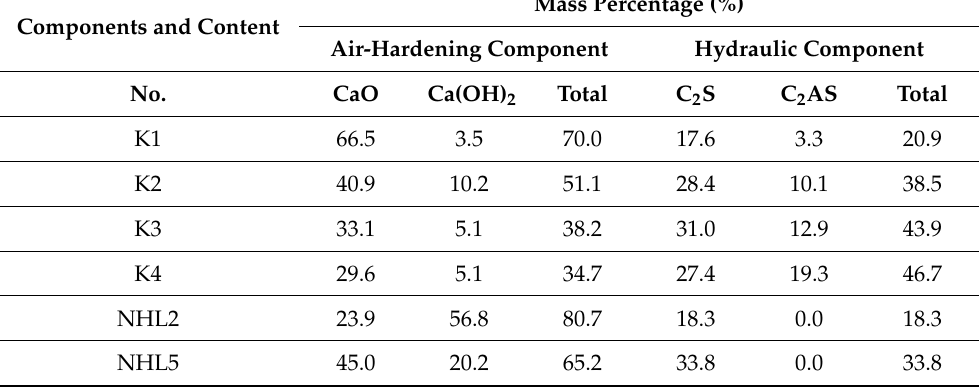
Table 2. Mass percentage of the air-hardening component and hydraulic component for K1, K2, K3, K4, NHL2, and